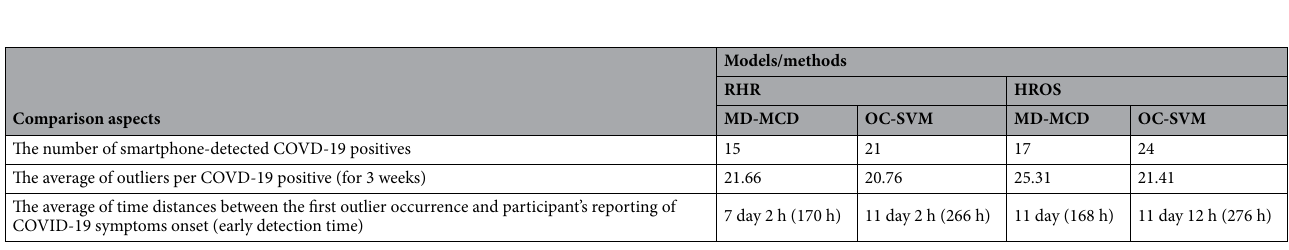
Table 2. A summary of Table